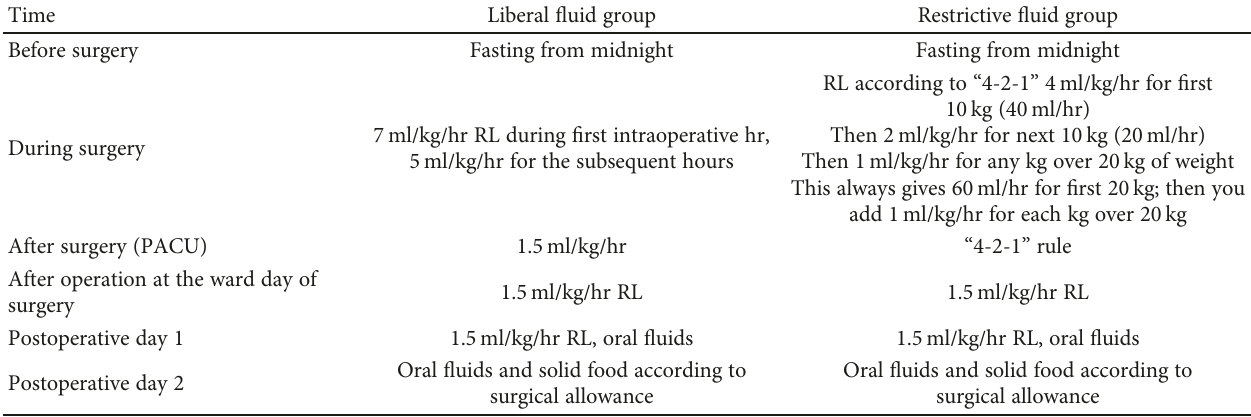
Table 1: Details of the two fl uid